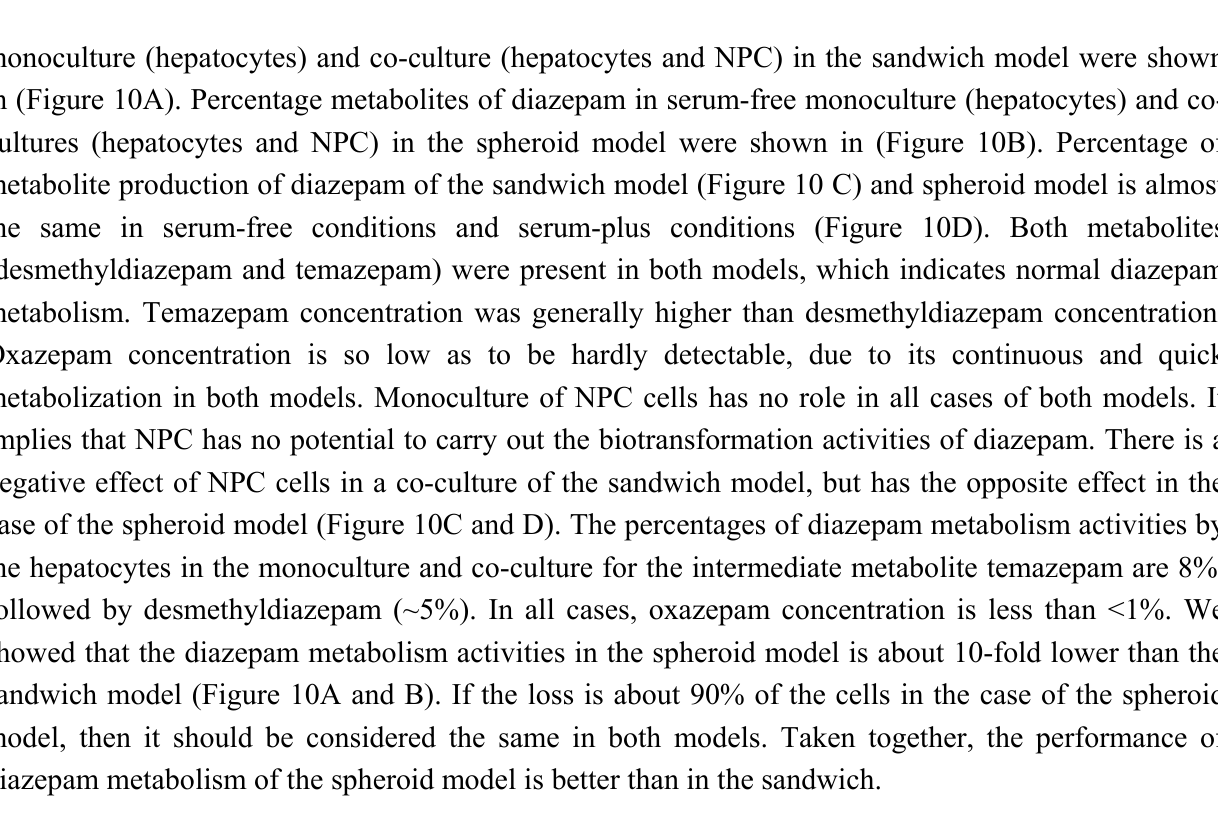
Figure 10. Diazepam metabolism in the sandwich and spheroid culture. (A) , Percentage of diazepam metabolism in mono- and co-cultures in the sandwich model; Hep, co-culture and NPC (B) , Percentage of diazepam metabolism in mono-and co-cultures in spheroid model; Hep, co-culture and NPC (C) Diazepam’s metabolite profile (percentage) in mono- and co-cultures in the sandwich model; Hep, co-culture and NPC, (D) Diazepam’s metabolite profile (percentage) inmono and co-cultures in the sandwich model; Hep, co- culture and NPC. Each point represents the mean ± S.E.M. of five experiments during which LDH activities were measured in